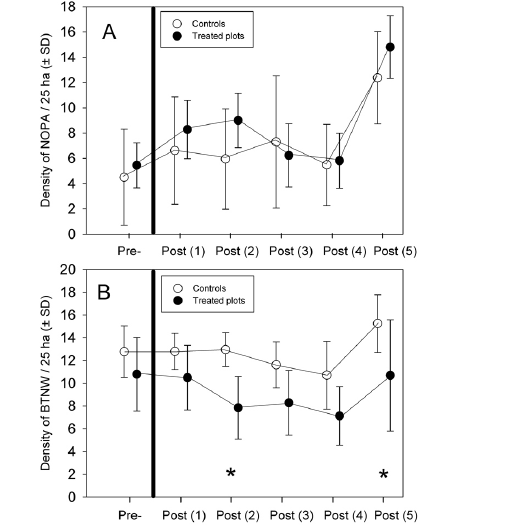
Fig. 4 . Mean (±SD) density of Yellow-bellied Sapsucker, Sphyrapicus varius (A) and Swainson’s Thrush, Catharus ustulatus (B) in treated plots and controls during one year preharvest and the first five years postharvest. The solid line delineates the pre- from the postharvest years and the asterisk (*) indicates a significant year-specific treatment